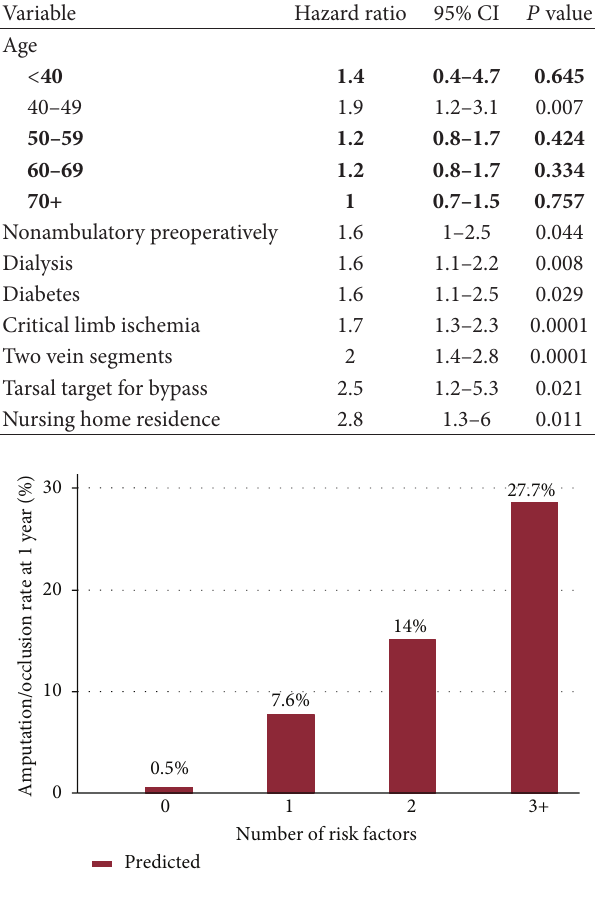
F 3: Predicted risk of amputation or gra occlusion, by the number of risk